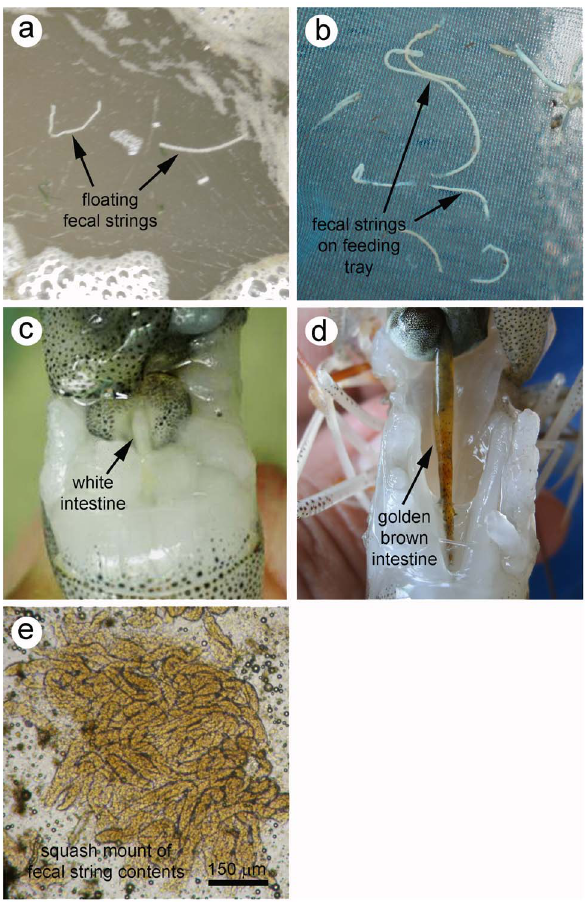
Figure 1. Gross signs of white feces syndrome WFS. (a) Floating, white fecal strings. (b) White fecal strings on a feeding tray. (c) White intestine of affected shrimp. (d) Golden brown intestine of an affected shrimp. (e) Photomicrograph of fecal string contents.